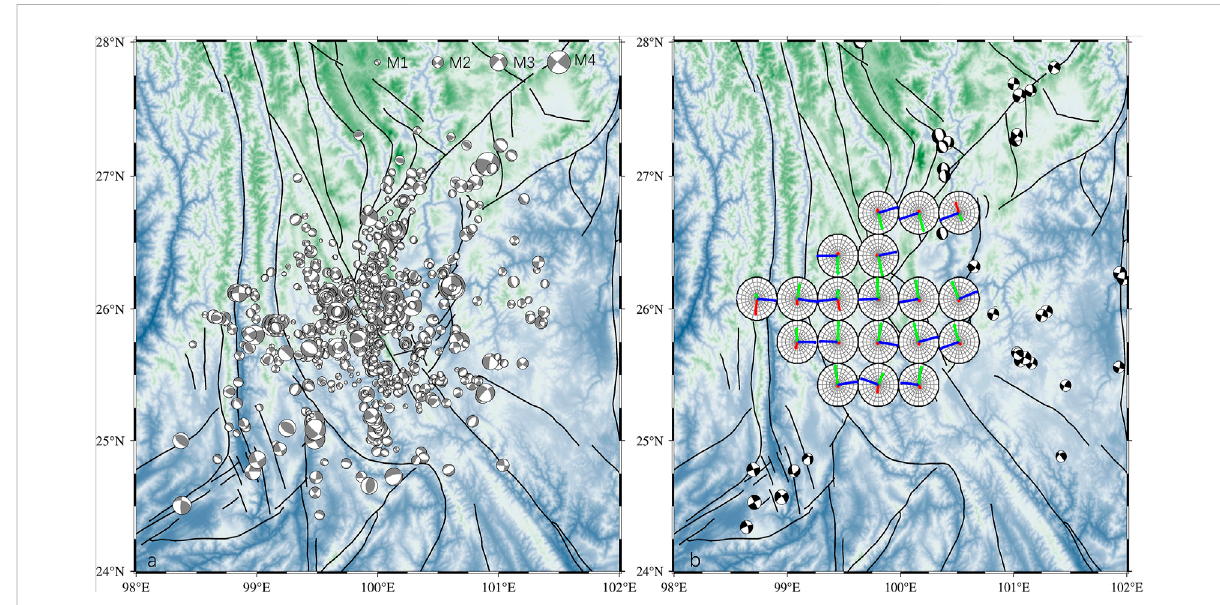
FIGURE 4 (A) DistributionoffocalmechanismsbasedonseismiceventsrecordedbythedigitalstationsshowninFigure1. (B) Projectionsonthehorizontal plane of the three principal stress axes inverted from the focal mechanisms displayed in (A) , including the maximum principal stress axes σ 1 (red), medium principal stress axes σ 2 (green), and minimum principal stress axes σ 3 (blue). The background focal mechanisms are from the global CMT catalogue for events with magnitudes above